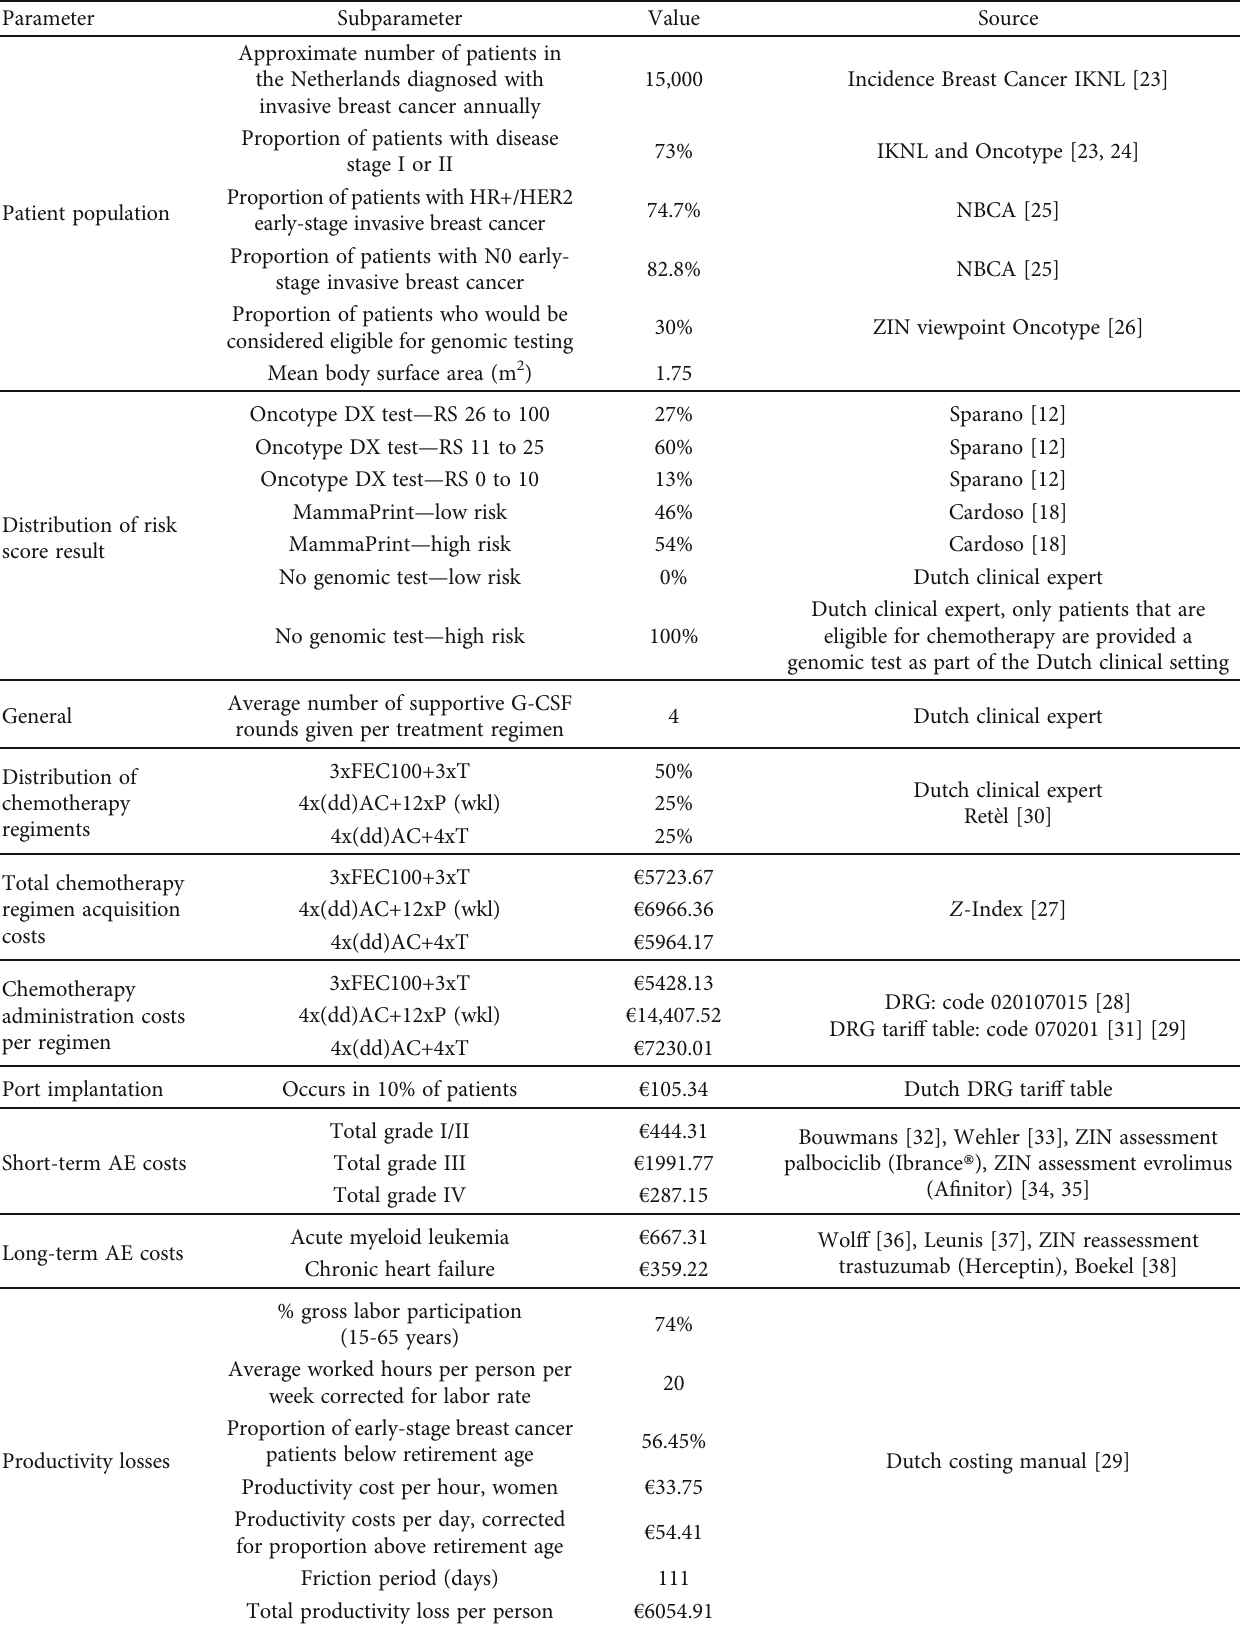
Table 1: The list of inputs/calculated inputs used in the cost-consequence model and their